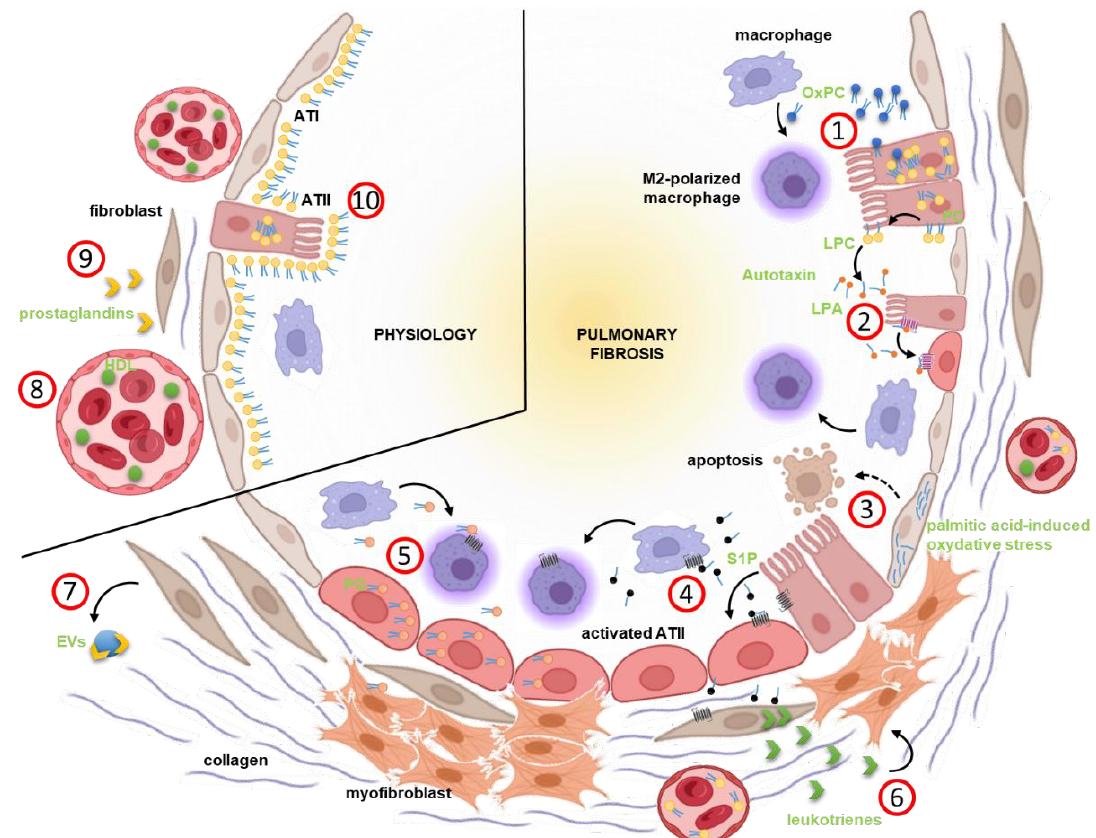
Figure 2. The role of extracellular lipids in the pathogenesis of pulmonary fibrosis. During pul- monary fibrosis, ( 1 ) impaired secretion of the surfactant lipids, mainly phosphatydil-choline (PC) promotes the accumulation of oxidized phospholipids, mainly oxidized-PC (OxPC). ( 2 ) PC are also a source of lysophosphate acid (LPA) after processing by autotaxin, which is increased during fi- brosis. ( 3 ) The accumulation of palmitic acid in alveolar epithelial cells results in major oxidative stress and ultimately apoptosis. ( 4 ) Sphingosine-1-phosphate (S1P) accumulates in the extracellular space and promotes the EMT of ATII cells. Further, ( 5 ) activated ATII cells produce large amount of phosphatydil-glycerol. All these lipids contribute to the polarization of local macrophages towards a profibrotic M2-phenotype or the activation of ATII cells. In addition, S1P has a supplemental role in the activation of aberrant ATII cells. Altogether, cell activation turns fibroblasts into pathological (myo)fibroblasts which ( 6 ) produce high levels of arachidonic acid derivatives with a high leukotriene to prostaglandin ratio. Of note, ( 7 ) inflammation-primed fibroblasts also secrete extracellular vesicles carrying prostaglandins. The increase in pulmonary lipids during fibrosis is linked to increased circulating PC. In normal conditions, ( 8 ) lower levels of blood PC are likely to be found with increased circulating HDL, and ( 9 ) arachidonic acid metabolism in fibroblasts results in leukotriene overproduction. ( 10 ) ATII cells produce surfactant-forming lipids (mainly PCs) to participate in lung surfactant homeostasis. Cell types (black) and lipids (light green) are labeled. Lipid profiling applied to bronchoalveolar lavage fluid (BALF) in experimental